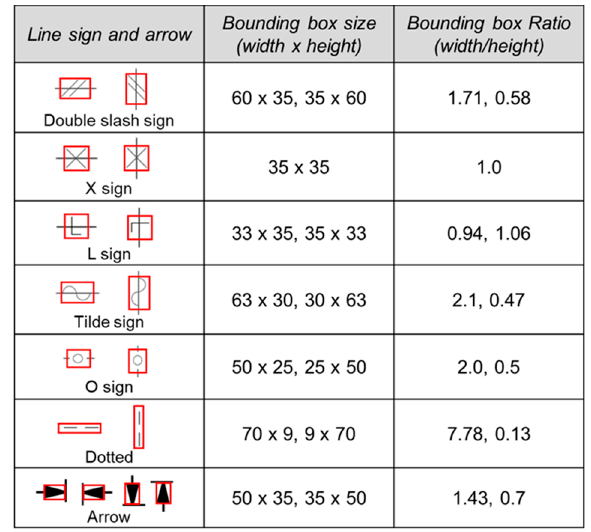
Figure 5. Bounding box sizes for line signs and flow arrows.